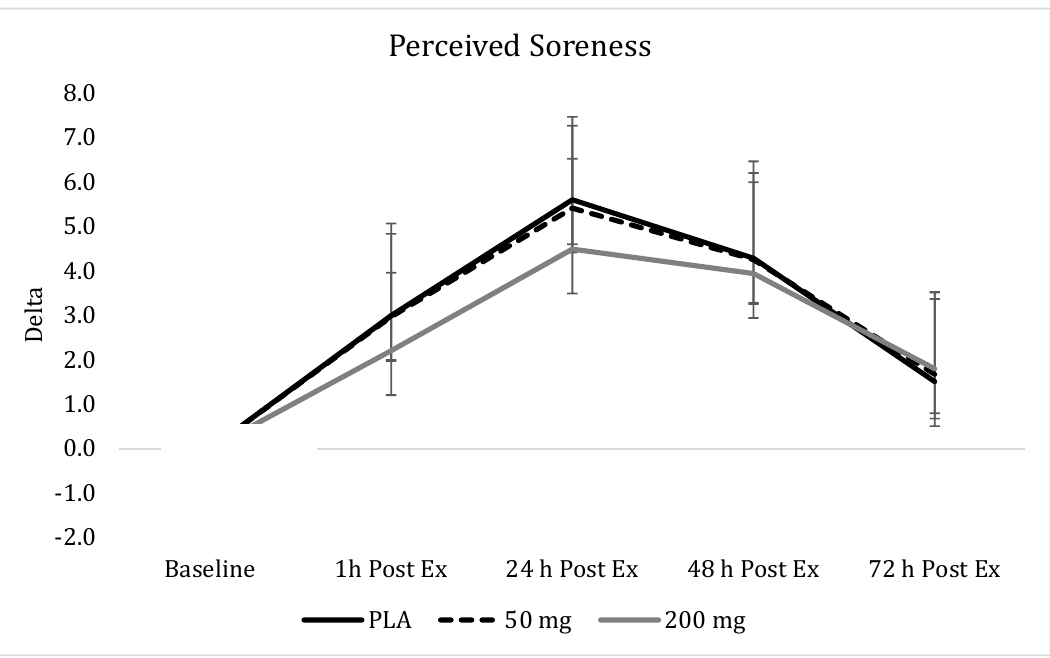
Figure 6. Perceived Total Thigh Soreness. Changes in perceived total thigh soreness 1 h, 24 h, 48 h, and 72 h post-muscle damaging exercise, downhill run, in placebo ( ), 50 mg of CUR (in the form of 250 mg of CurcuWIN ® ) ( ), and 200 mg of CUR (in the form of 1000 mg of CurcuWIN ® ) ( ).